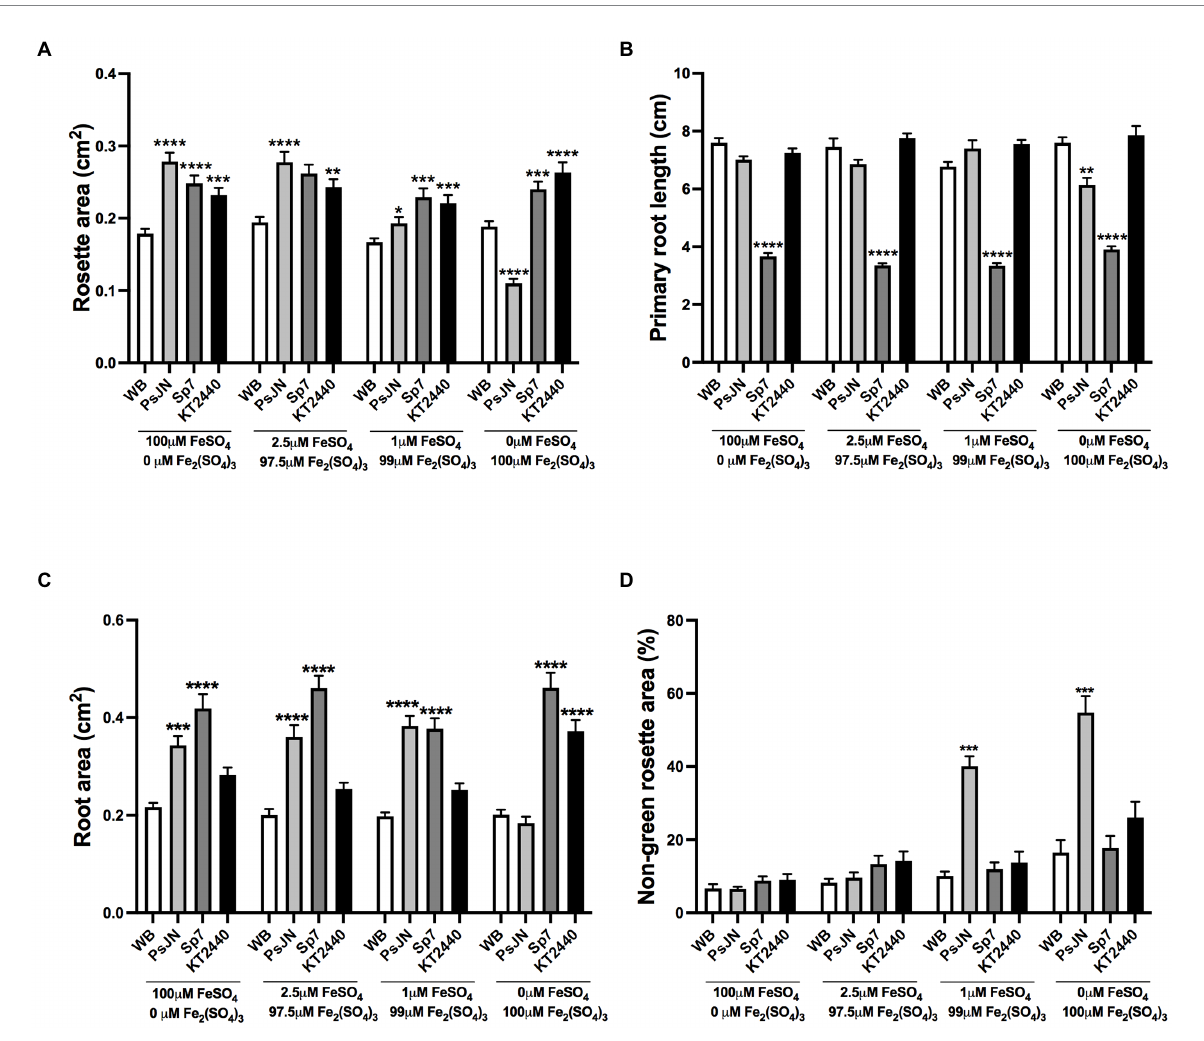
FIGURE 3 Effects of different sources of iron in plant growth and stress parameters in Arabidopsis thaliana inoculated with beneficial rhizobacteria. Rosette area (A) , primary root length (B) , root area (C) , and non-green rosette area (D) in plants 15 days after sowing in media with different concentrations of FeSO 4 or Fe 2 (SO 4 ) 3 , as an iron source with high or low solubility, respectively (Factor 1). A second factor corresponds to the inoculation, where non-inoculated plants are noted as WB, and inoculations with Paraburkholderia phytofirmans PsJN, Azospirillum brasilense Sp7, or Pseudomonas putida KT2440 are noted as PsJN, Sp7, and KT2440, respectively. Data are means ± SE of 30 replicates per treatment. Asterisks indicate significant differences between each treatment and their respective WB treatment (Kruskal–Wallis test, * p < 0.05; ** p < 0.01; *** p < 0.001; and **** p <